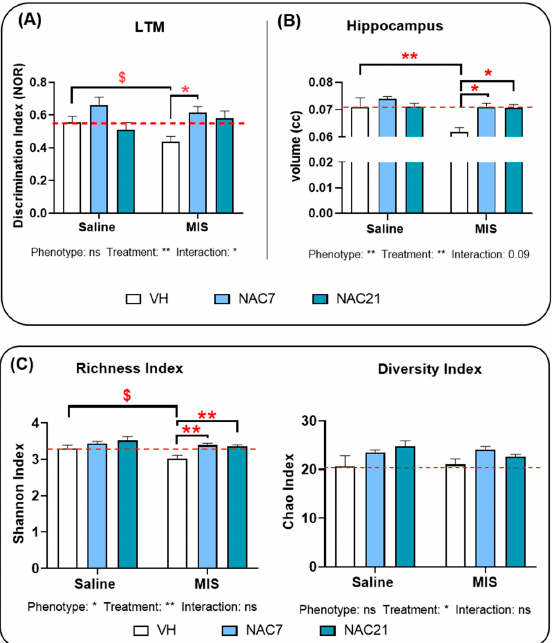
Figure 1. ( A ) Discrimination index. The effect of NAC treatment on the long-term memory (LTM) discrimination index between objects in the novel object recognition test (NOR) (Saline VH, N = 9; Saline NAC7, N = 6; Saline NAC21, N = 8; MIS VH, N = 7; MIS NAC7, N = 8; MIS NAC21, N = 6). ( B ). Hippocampal volume. The effect of NAC on hippocampal volume in the Saline (control) and MIS (pathological) animal groups, measured by MRI. (Saline VH, N = 7; Saline NAC7, N = 12; Saline NAC21, N = 12; MIS VH, N = 6; MIS NAC7, N = 12; MIS NAC21, N = 12). ( C ). Bacterial diversity and richness . Representation of the changes in bacterial diversity and richness, as measured by Shannon and Chao Indexes in Saline and MIS animals after a preventive treatment with NAC during pregnancy. (Saline VH, N = 8; Saline NAC7, N = 11; Saline NAC21, N = 11; MIS VH, N = 11; MIS NAC7, N = 10; MIS NAC21, N = 9). [Data is shown as mean ± SEM. 2-way ANOVA followed by a posthoc test, Tukey’s multiple comparison (* p < 0.05, ** p < 0.01) and unpaired t -test ( $ p < 0.05) are shown. ns: non-significant]. The red dotted line indicates the mean value of the control group